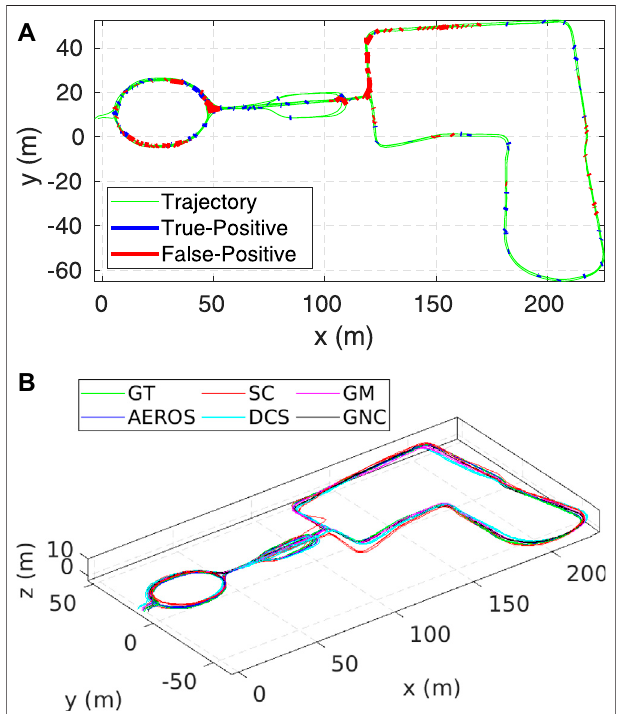
FIGURE 10 | (A) : Ground Truth trajectory of the Newer College dataset (the long experiment). The blue and red lines indicate the correct and the incorrect loop closures, respectively. Each line connects two nodes of the pose graph — the head and the tail of the loop closure edge. (B) : A 3D view of the trajectory estimated by the AEROS algorithm (blue) versus the SC solution (red), compared to the ground truth (green).